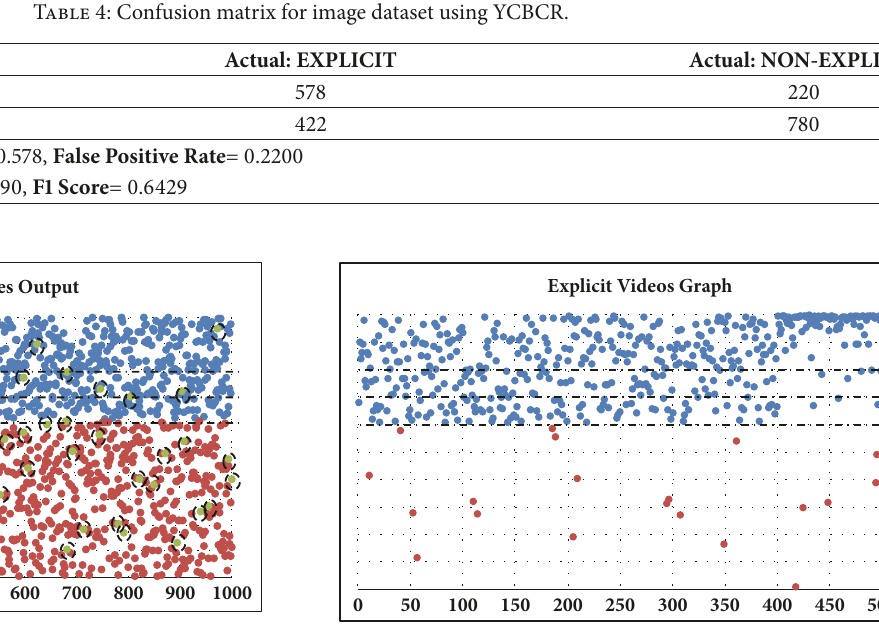
Figure 13: Result graph of application of proposed ECD system on complete (explicit/nonexplicit) dataset images.